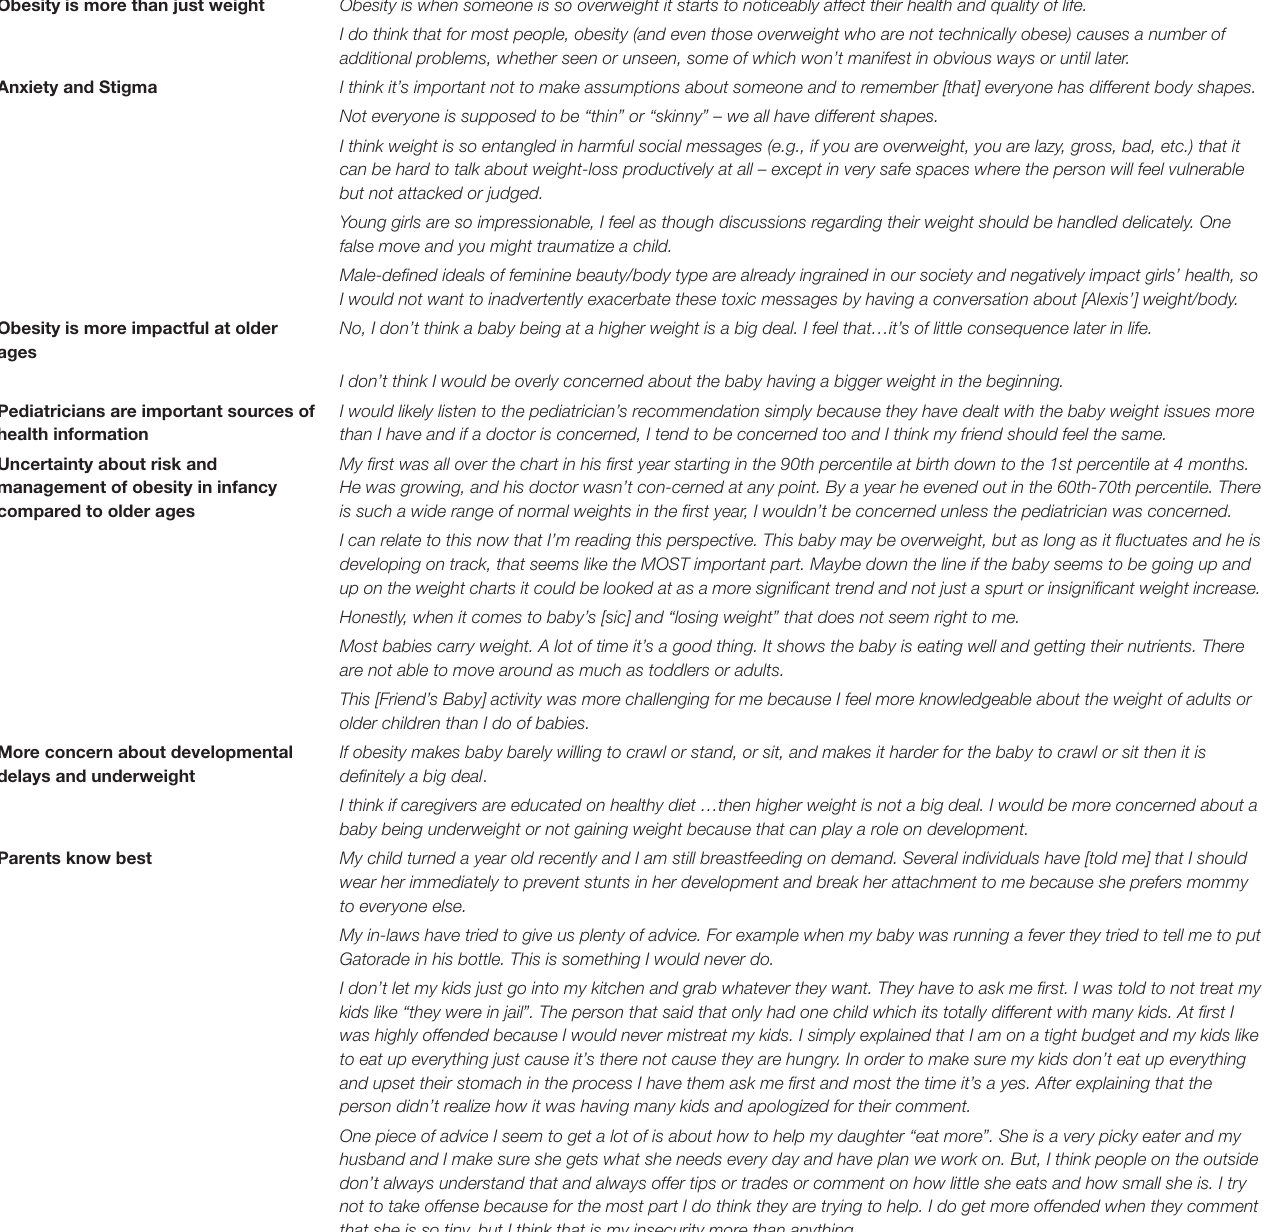
TABLE 3 | Parental views about obesity and obesity risk in the first 1,000 days: additional statements from the persona/empathy map activities. Obesity is more than just weight Obesity is when someone is so overweight it starts to noticeably affect their health and quality of life.